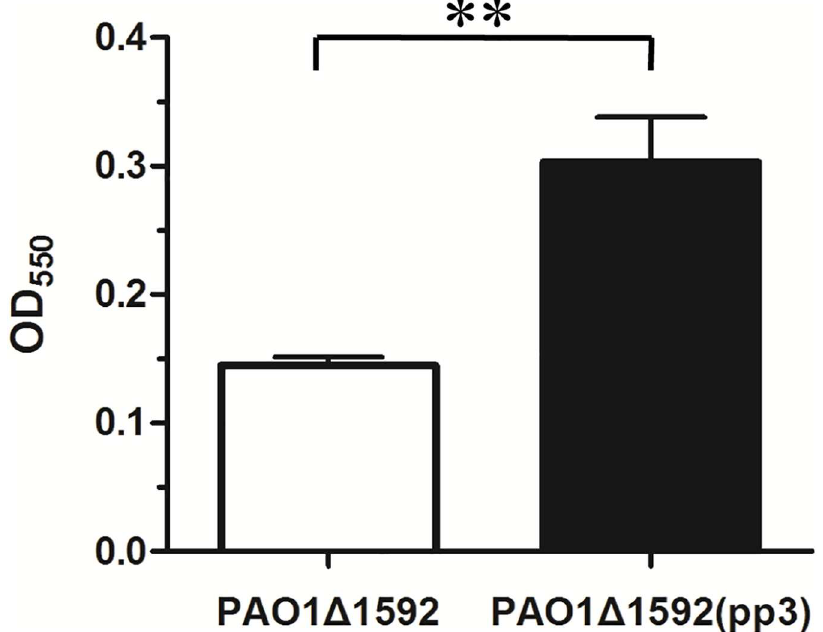
Fig 5. Biofilm formation is increased by transfer of pp3. Data are from three independentexperiments and are shown as means ± standarddeviations. ** , P < 0.01.